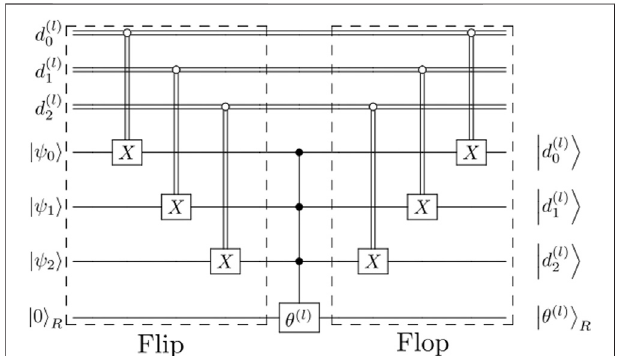
FIGURE 3 | Quantum circuit corresponding to one Flip-Flop iteration of the FF-qRAM algorithm. The classically-controlled operations X are applied to the states | ψ j 〉 , and the register | 0 〉 R can include the probability amplitudes for encoding. Note that the complete superposition creation requires the complete circuit implementation. Adapted from